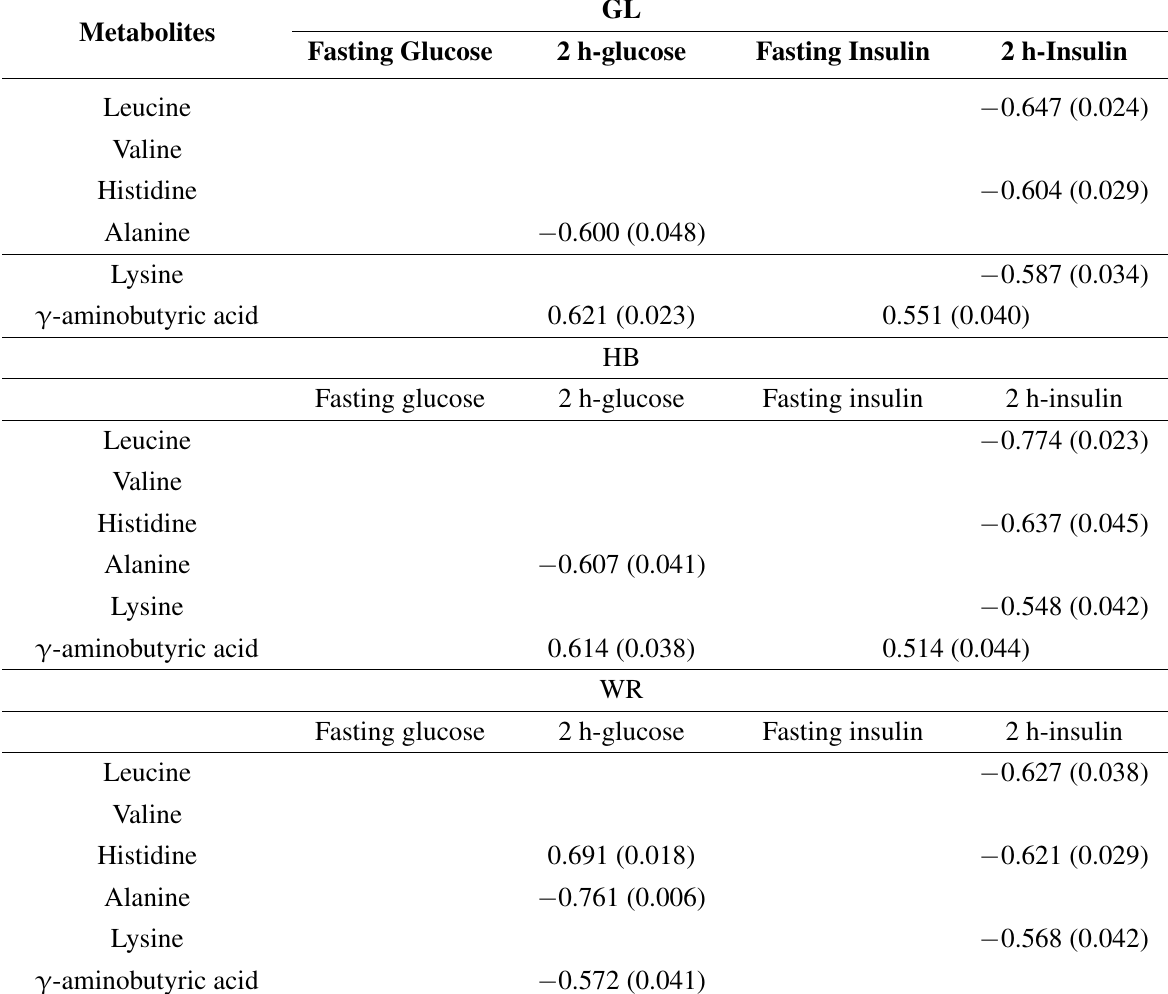
Table 2. Associations between glucose, insulin and insulin sensitivity index and percent change of metabolites from fasting to 2-h sample response to three test